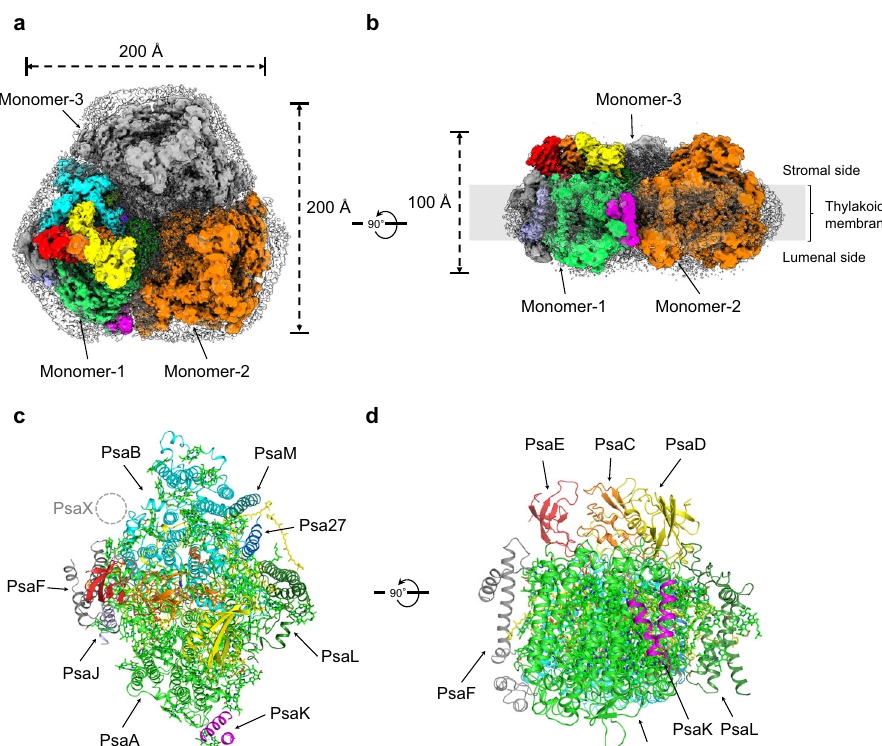
Fig. 2 Overall structure of the photosystem I (PSI) trimer from Acaryochloris marina . a Cryo-electron microscopy (cryo-EM) density map of PSI trimer viewed from the stromal side perpendicular to the membrane plane. Monomer-1, multicolored; monomer-2, orange; monomer-3, gray; detergent micelle, cloudy gray. b Cryo-EM density map of PSI trimer viewed from the side of the membrane plane. c Structural model of PSI monomer with view in the same direction as in a . PsaA, green; PsaB, cyan; PsaC, orange; PsaD, yellow; PsaE, red; PsaF, gray; PsaJ, light blue; PsaK, magenta; PsaL, dark green; PsaM, teal blue; Psa27, blue. d Structural model of PSI monomer with view in the same direction as in b (Fig. 3d; 3.6 Å in T. elongatus ). Two Tyr residues, Tyr601/A and Tyr733/A, are positioned within hydrogen bonding distance of P A as observed in PSI from T. elongatus .